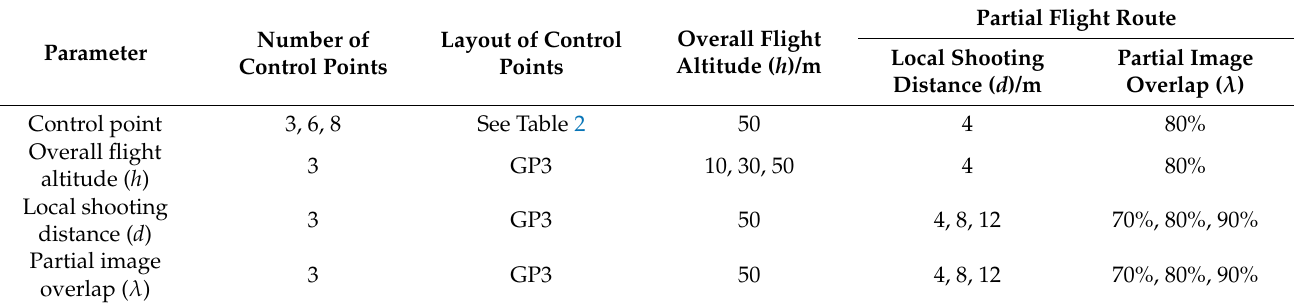
Table 1. Summary of parameters for experiments.